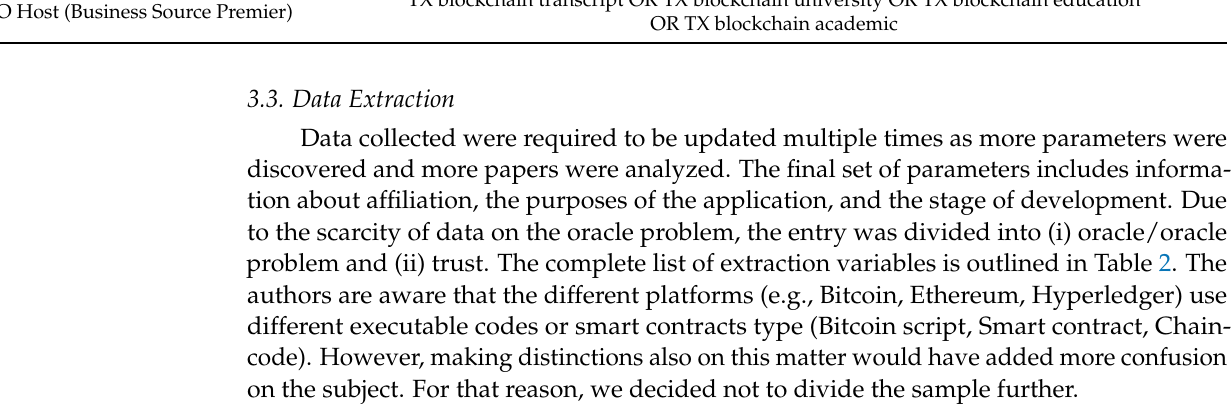
Table 2. Data extraction from